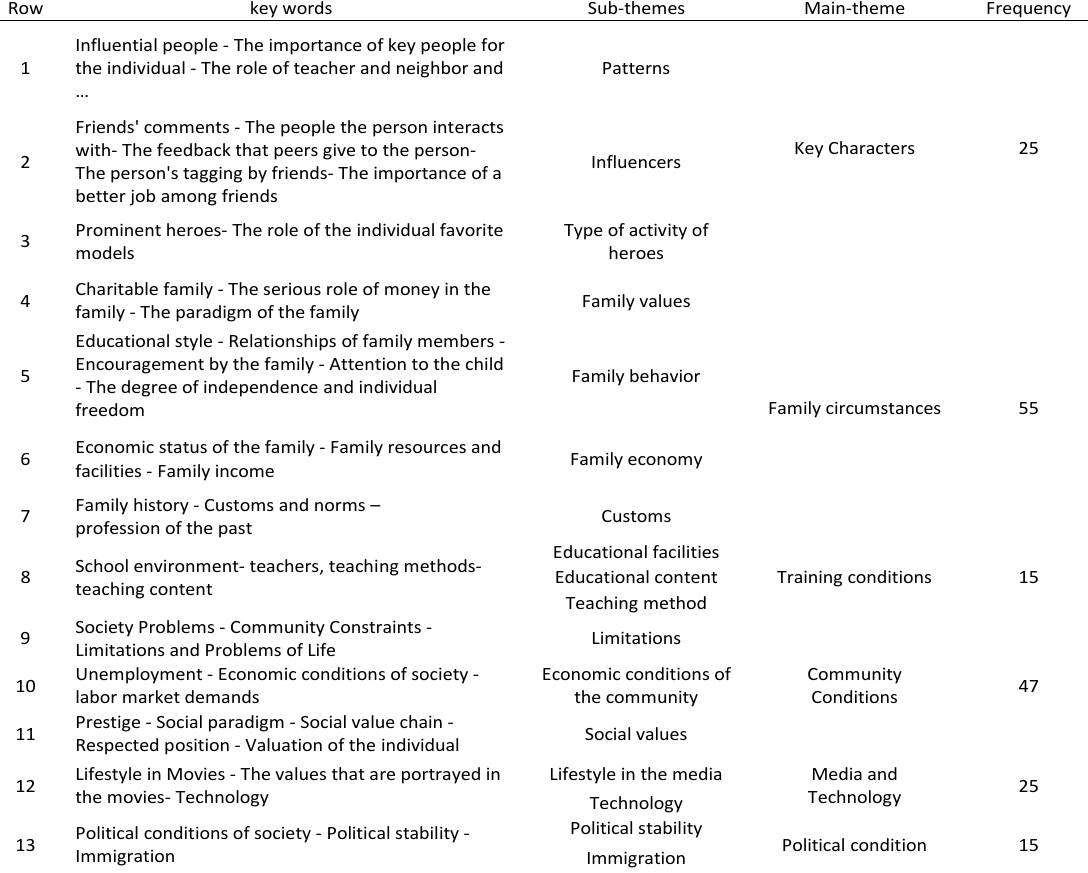
Table 3: Descriptive keywords, Sub-themes and Main-themes at the environmental level Row key words